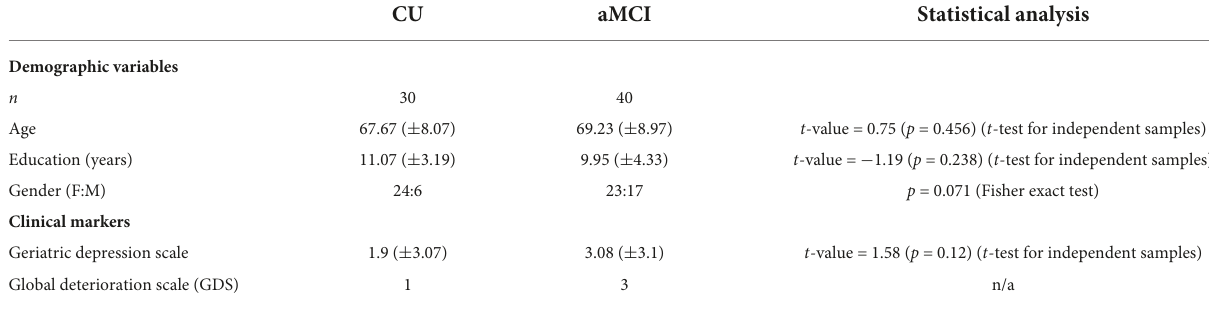
TABLE 1 Mean values ( ± SD) of the demographic and clinical data in the groups of CU and aMCI seniors, and p -value of their statistical